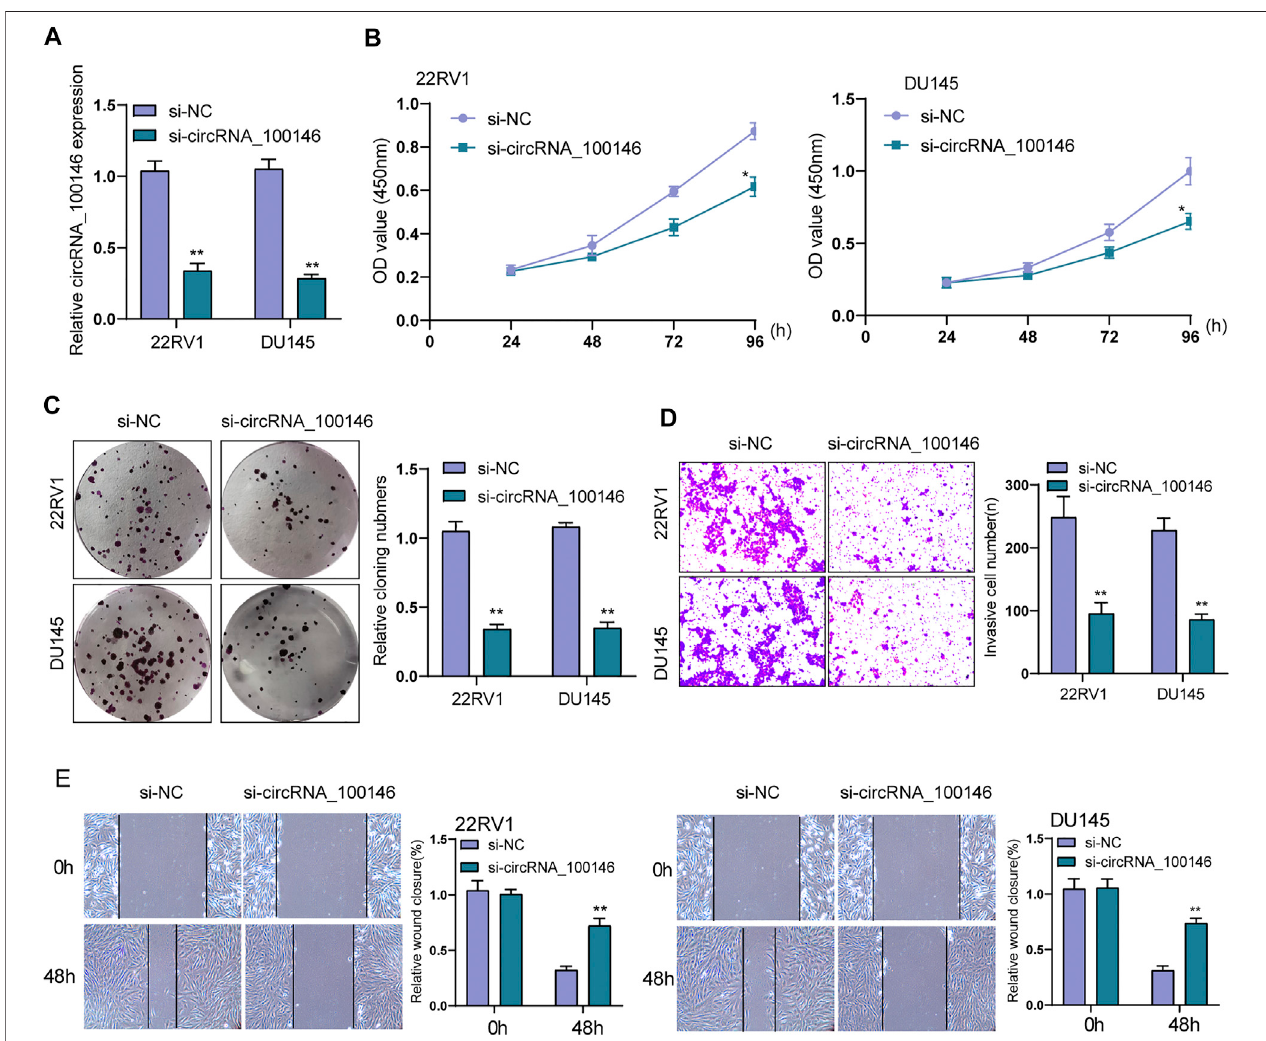
FIGURE2| EffectsofcircRNA_100146 knockdown ontheproliferationand metastasis ofPCa cells. (A) Theexpression ofcircRNA_100146 in22RV1and DU145 cells transfected with si-NC or si-circRNA_100146. (B) CCK-8 assays for the proliferative determination in 22RV1 and DU145 cells after circRNA_100146 knockdown. (C) Cells with transfection of control siRNA or circRNA_100146 siRNAs were examined by colony formation assays. (D) Transwell assay indicated the invaded cell number in 22RV1 and DU145 cells transfected with si-circRNA_100146 and si-NC. (E) Representative images and quantitative analysis of scratch assays, and delayed closure was observed in 22RV1 and DU145 cells with circRNA_100146 knockdown. ** p < 0.01, * p < 0.05.